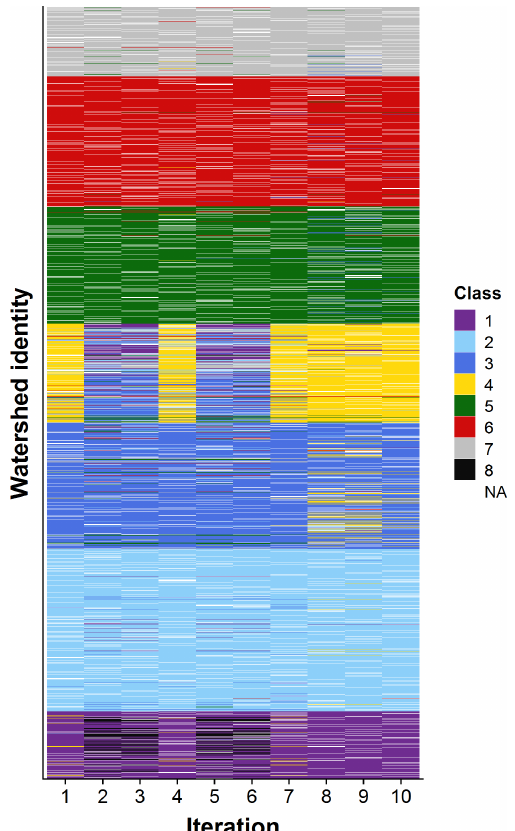
Figure 10. Agreement of assigned watershed classification from the (original) complete analysis, with class assignments from the itera- tive approach using re-sampling. Classes are coloured according to that shown in Fig. 5, with those identified under a new class ( C 8 ) depicted in black. Watersheds that were removed from the sub- sets analyzed are in white. Classes: Southern Manitoba (1), Pot- hole Till (2), Pothole Glaciolacustrine (3), Major River Valleys (4), Interior Grasslands (5), High Elevation Grasslands (6), Sloped In- cised